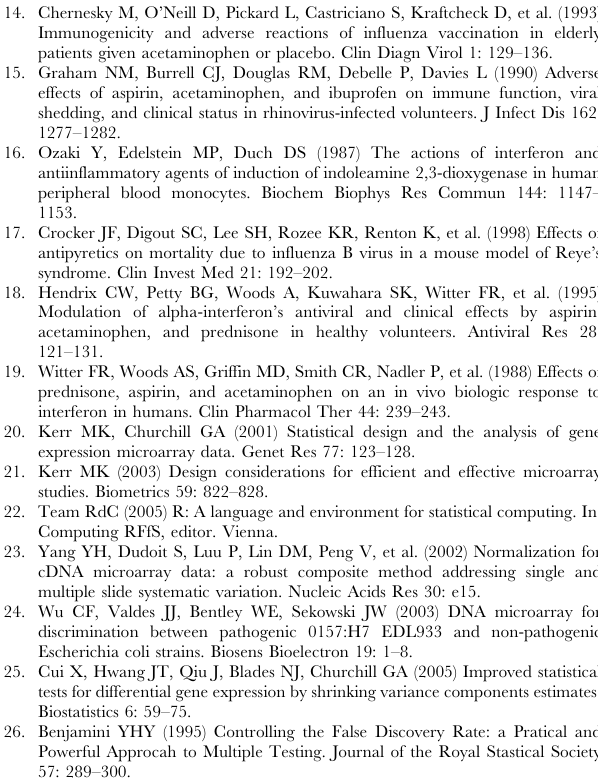
Table S1 A summary of all the significantly altered probes detected at an FDR of , 0.05.